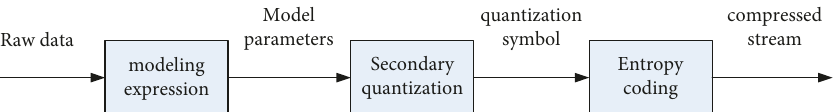
Figure 2: General steps for data